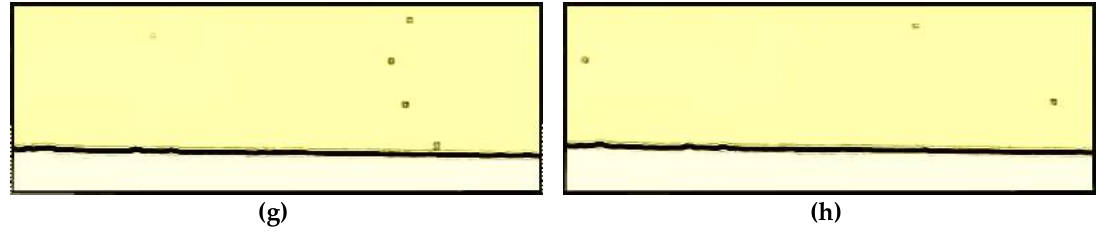
Figure 5. Graphs (a)-(h) show frames in chronological order. The frames show how particles moves from left to right along the membrane (in the bottom of each frame) during filtration of lowly charged particles at a crossflow velocity of 0.33 m/s and 2 bar TMP. The difference in time between the frames is 0.2 s.